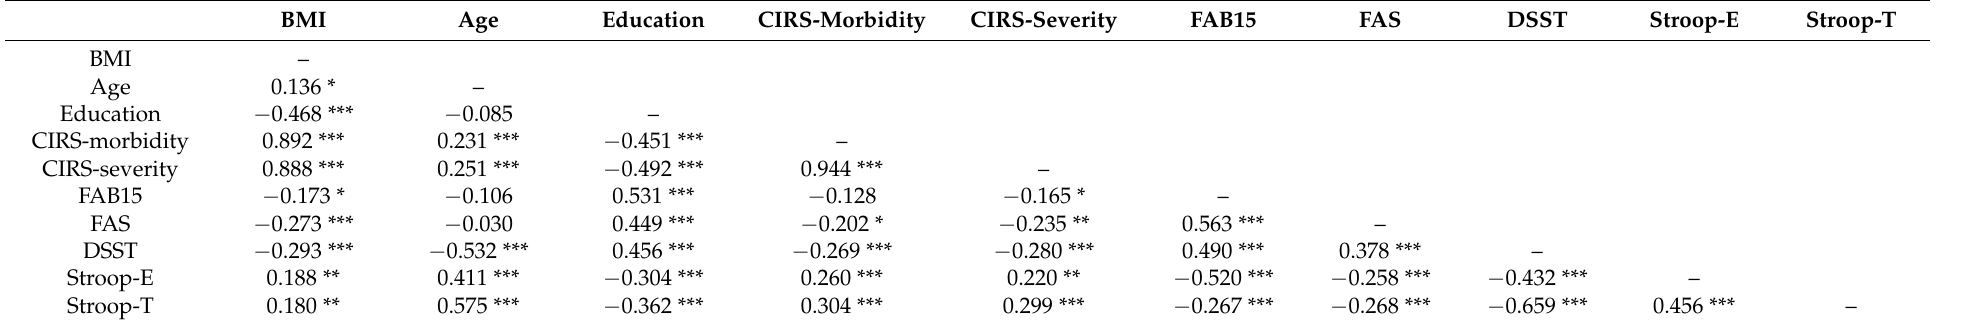
Table 2. Correlation